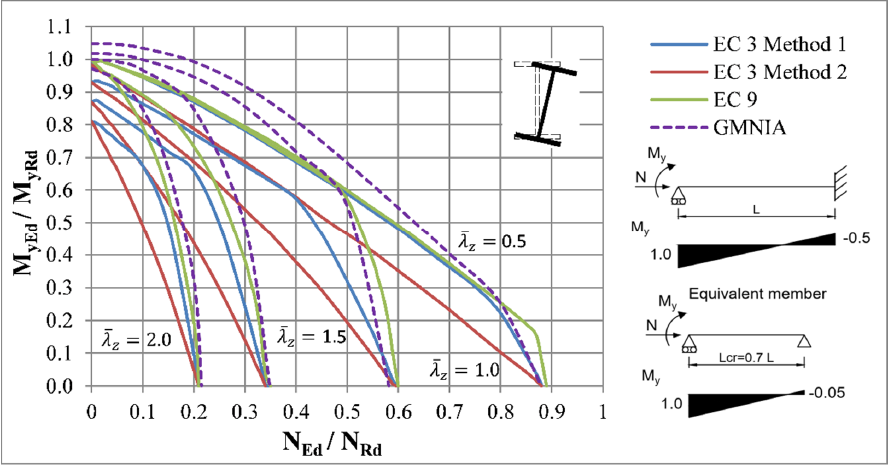
Figure 14. Interaction curves for laterally unrestrained beam-columns with IPE 100 cross-section with restrained warping.